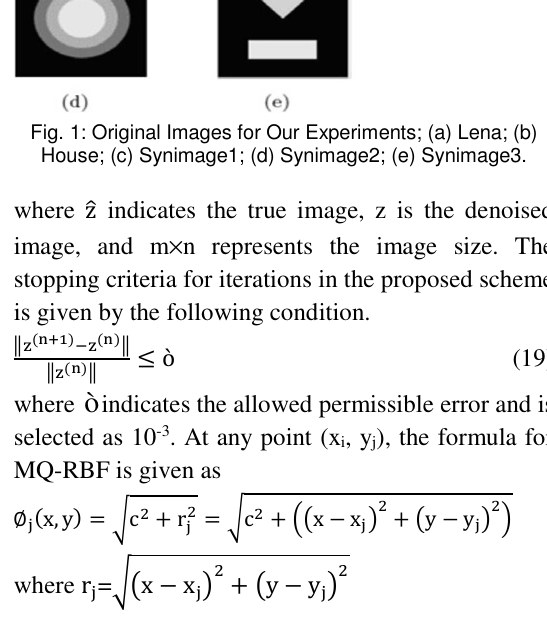
Figs. 2-3 present the first experiment on real images “Lena” and “House”. The original and noisy images with noise levels are shown in Fig. 2(a-b)-3(a-b),